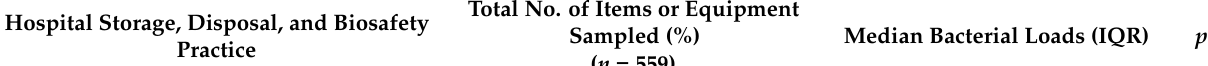
Table 2. Impact of biosafety practices on bacterial loads in the study